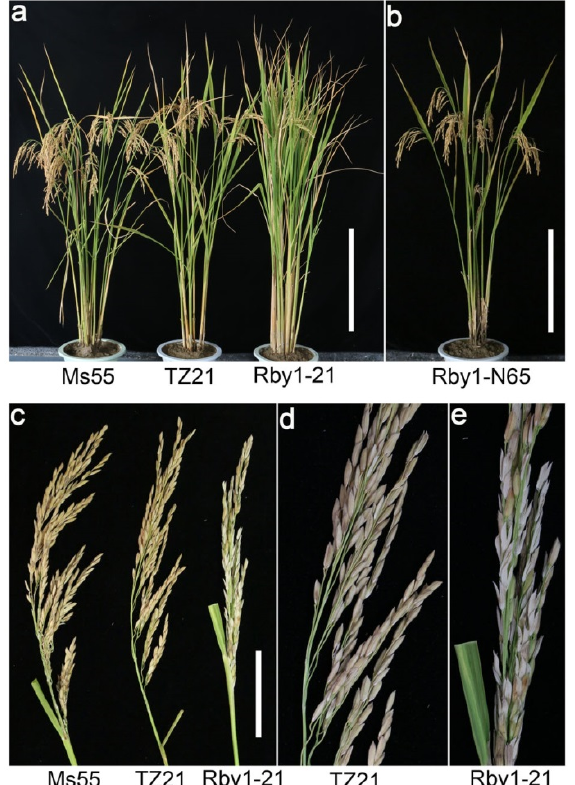
Figure 1. Phenotypic analysis of first-generation rice backcrosses. ( a ) Mature Ms55 ( left ), TZ21 ( middle ), and Rby1-21 ( right ). Rby1-21 is shown as representative rice plants from lines Rby1 and Rby2 infested by BPH, rice plants were grown in soil for 18 weeks. Bar = 30 cm; ( b ) Mature Rby1-N65. Rby1-N65 is shown as a representative rice plant from line Rby1 or Rby2 not infested with BPH. Bar = 30 cm; ( c ) mature panicles of TZ21 ( left ), Ms55 ( middle ), and Rby1-21 ( right ). Bar = 10 cm; ( d ) large images of TZ21 panicle; ( e ) large image of Rby1-21 panicle.